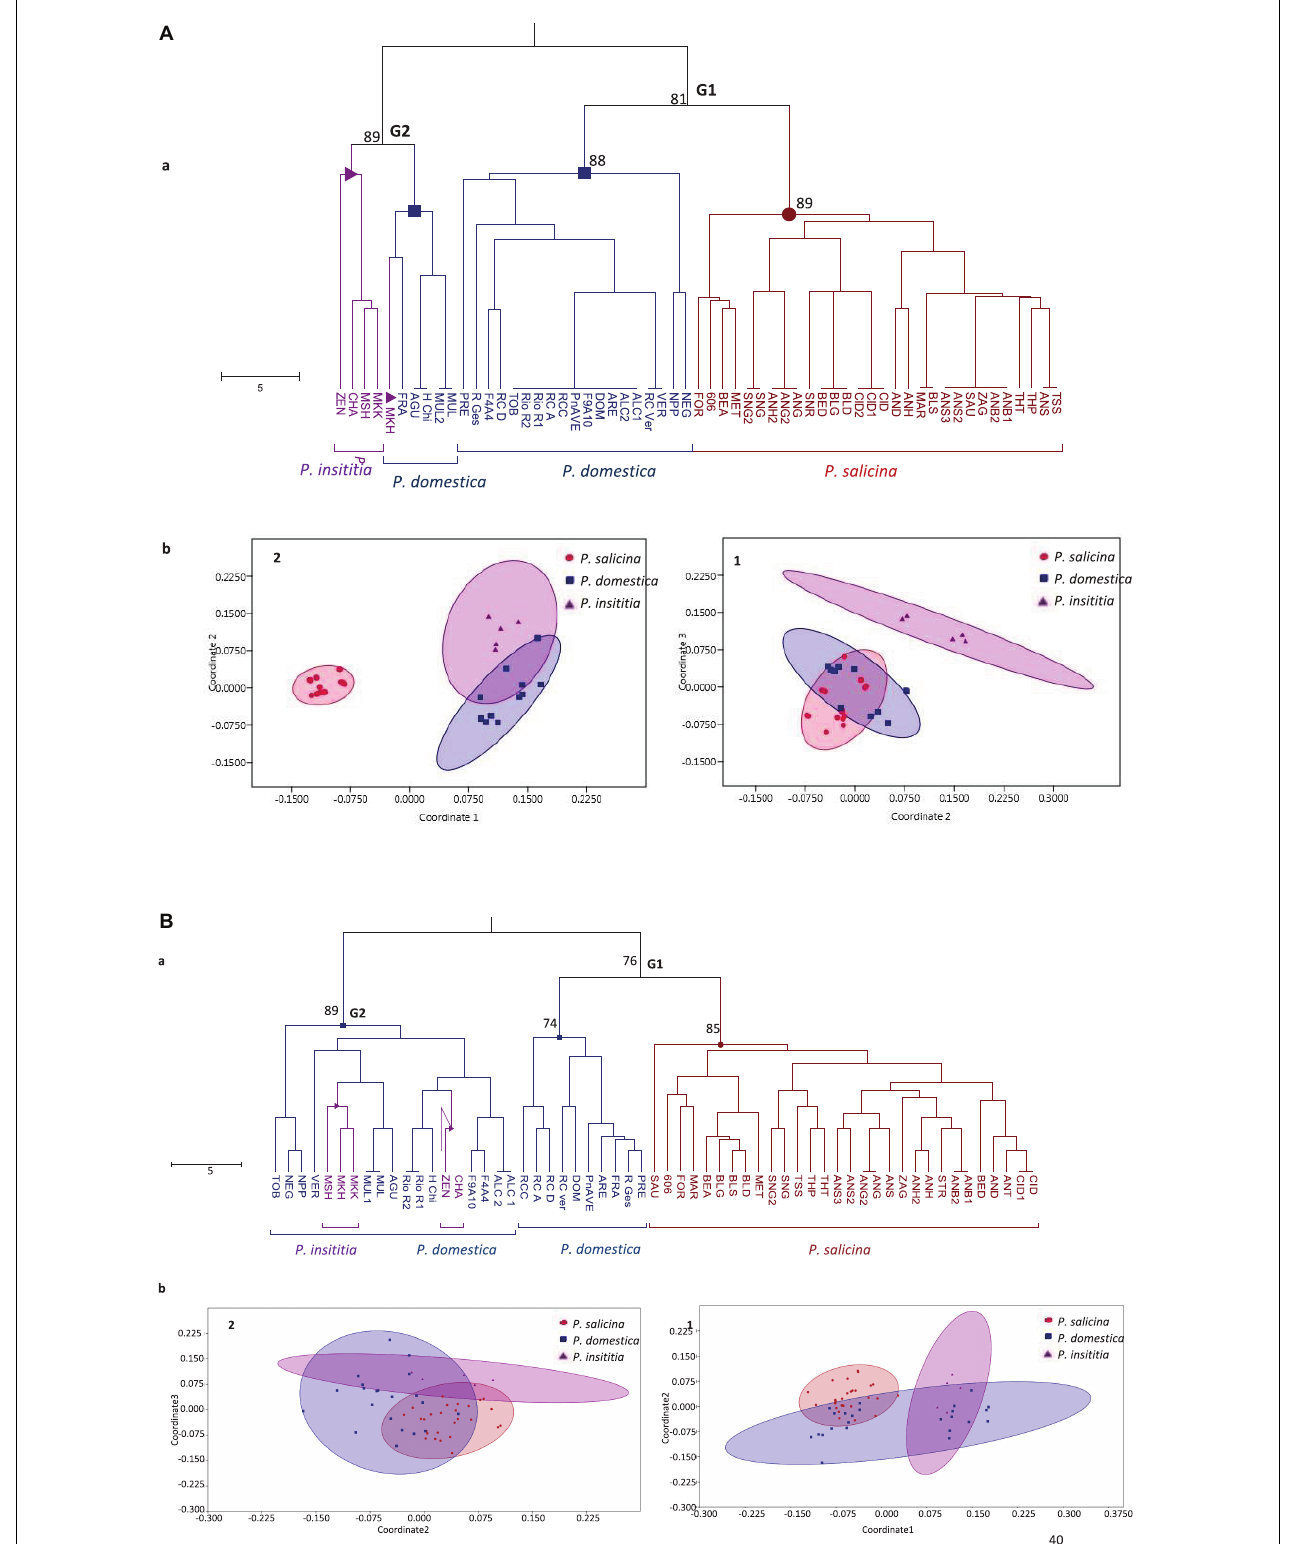
FIGURE 3 | Genetic relationships between the 59 tested plums based on (A) S- locus data and (B) SSR data. (a) UPGMA tree. Numbers on major branches represent bootstrap support from 2000 replicates. (b) Non-metric multidimensional scaling MDS plots: (1) using dimensions 2–3. (2) using dimensions 1–2.